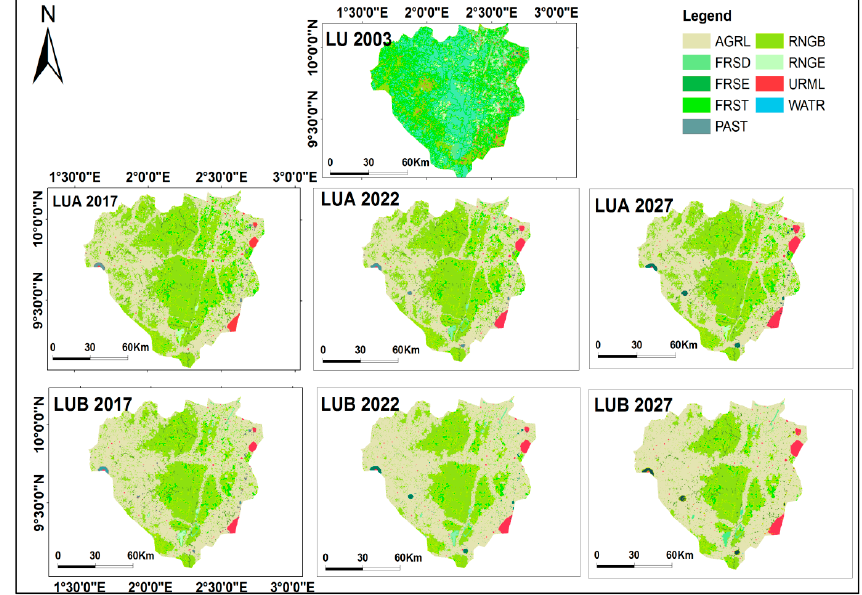
Figure 7. Land use/cover scenarios. The different land use types are forest-deciduous (FRSD), forest-mixed (FRST), range-bush (RNGB), agriculture (AGRL), forest-evergreen (FRSE), range-grasses (RNGE), water bodies (WATR), pasture (PAST), and urban area (URML).